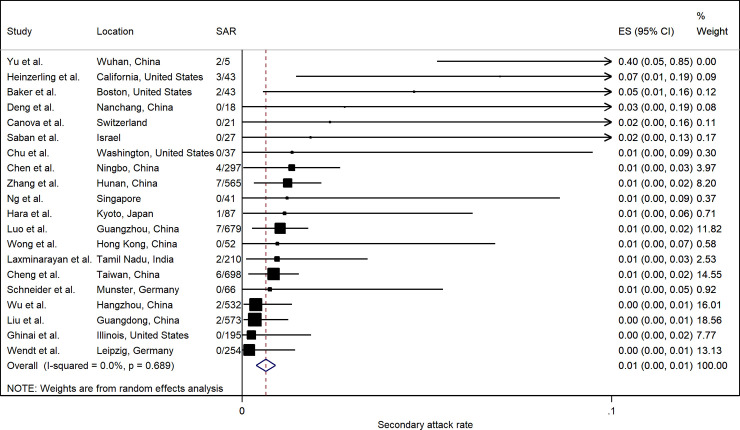
Forest plot of secondary attack rates (SAR) in healthcare settings.ES is the estimated SAR, with 95% confidence intervals (CI). I-squared is the percentage of between-study heterogeneity that is attributable to variability in the true effect, rather than sampling variation.